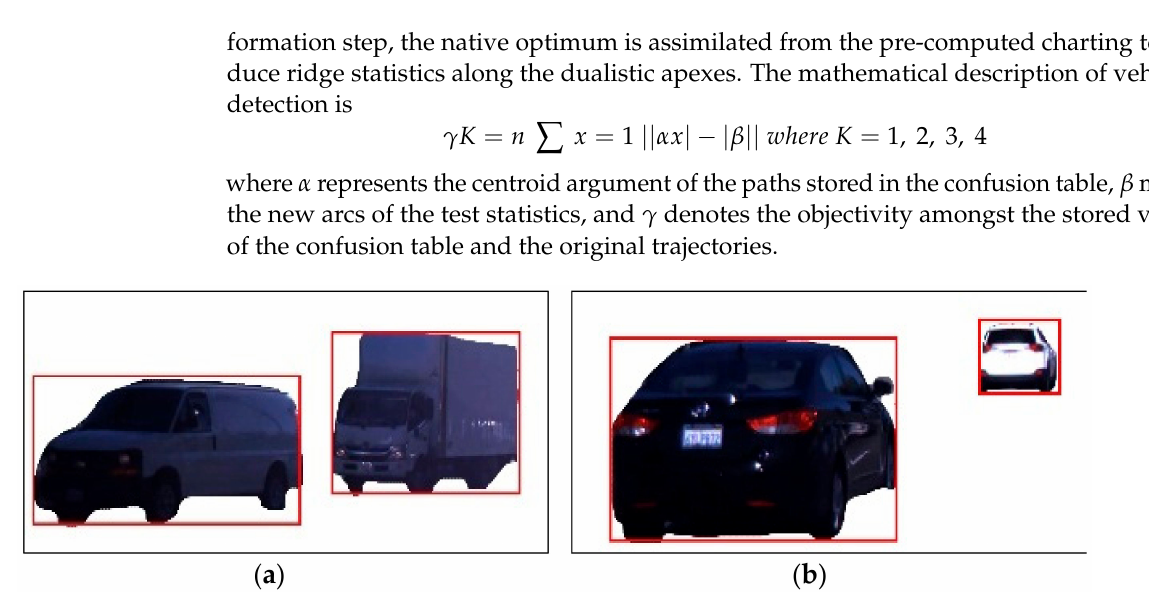
Figure 5. Example results of extracting region of interest. ( a ) front ( b ) back.